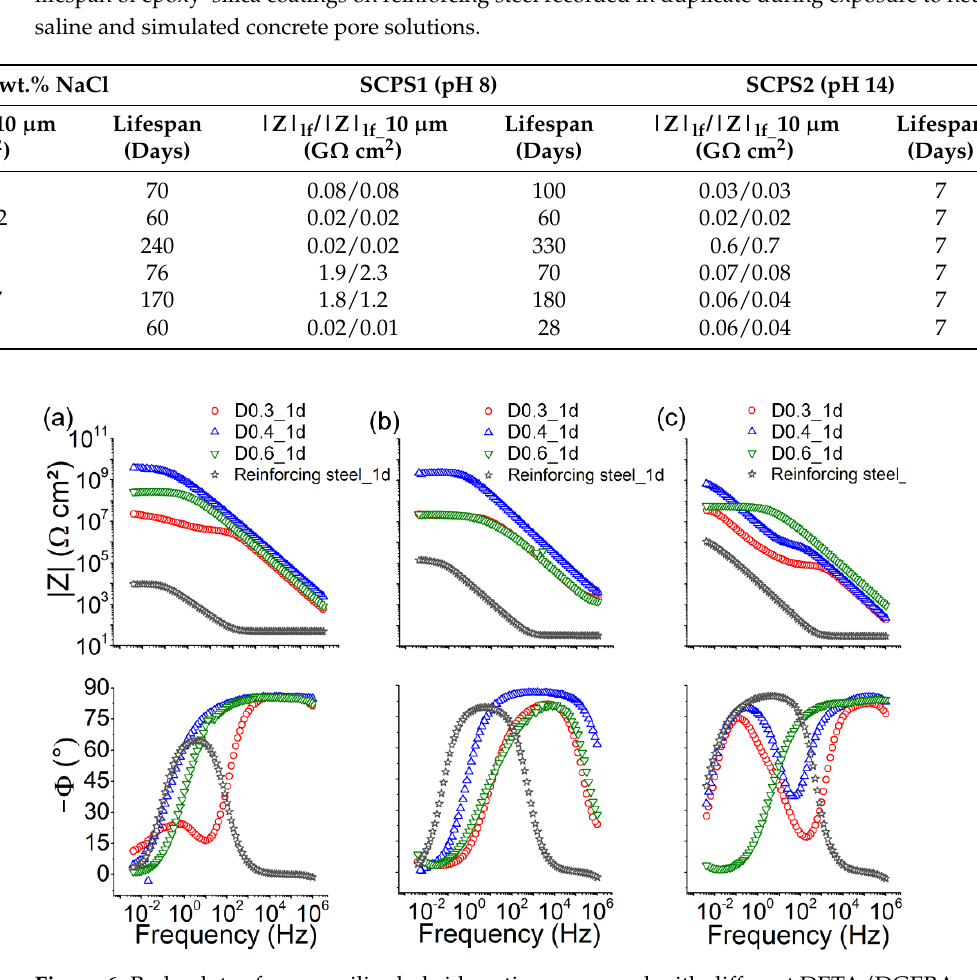
Figure 6. Bode plots of epoxy – silica hybrid coatings prepared with different DETA/DGEBA ratios after 1 day of exposure in solution: ( a ) 3.5 wt.% NaCl, ( b ) SCPS1 (pH 8), and ( c ) SCPS2 (pH 14).